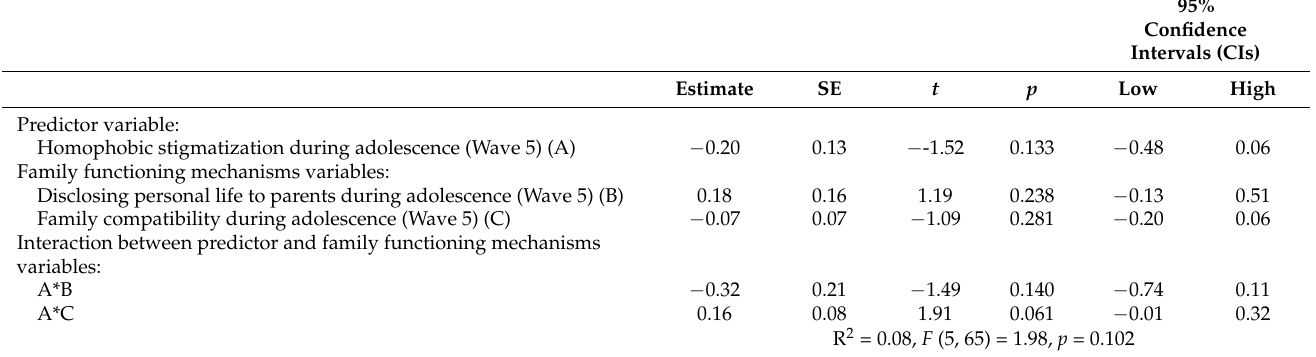
Table 4. The moderating effect of disclosing personal life to parents and family compatibility during adolescence (Wave 5) on the relationship between homophobic stigmatization during adolescence (Wave 5) and positive affect during emerging adulthood (Wave